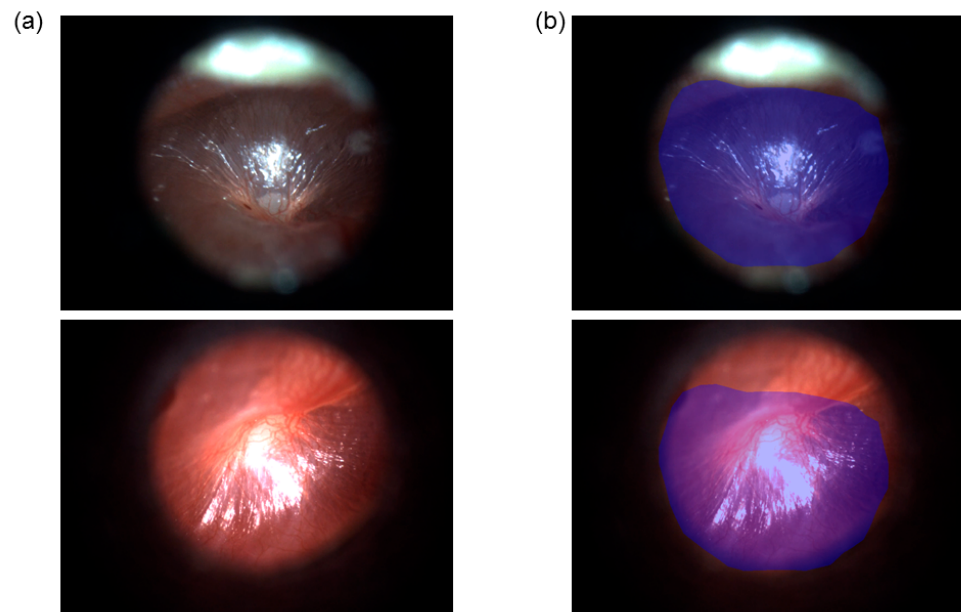
Figure 2. Examples of annotation. ( a ) Original tympanic otoscopy images; ( b ) annotated images. Glare and blur are excluded from the target area by the annotator.